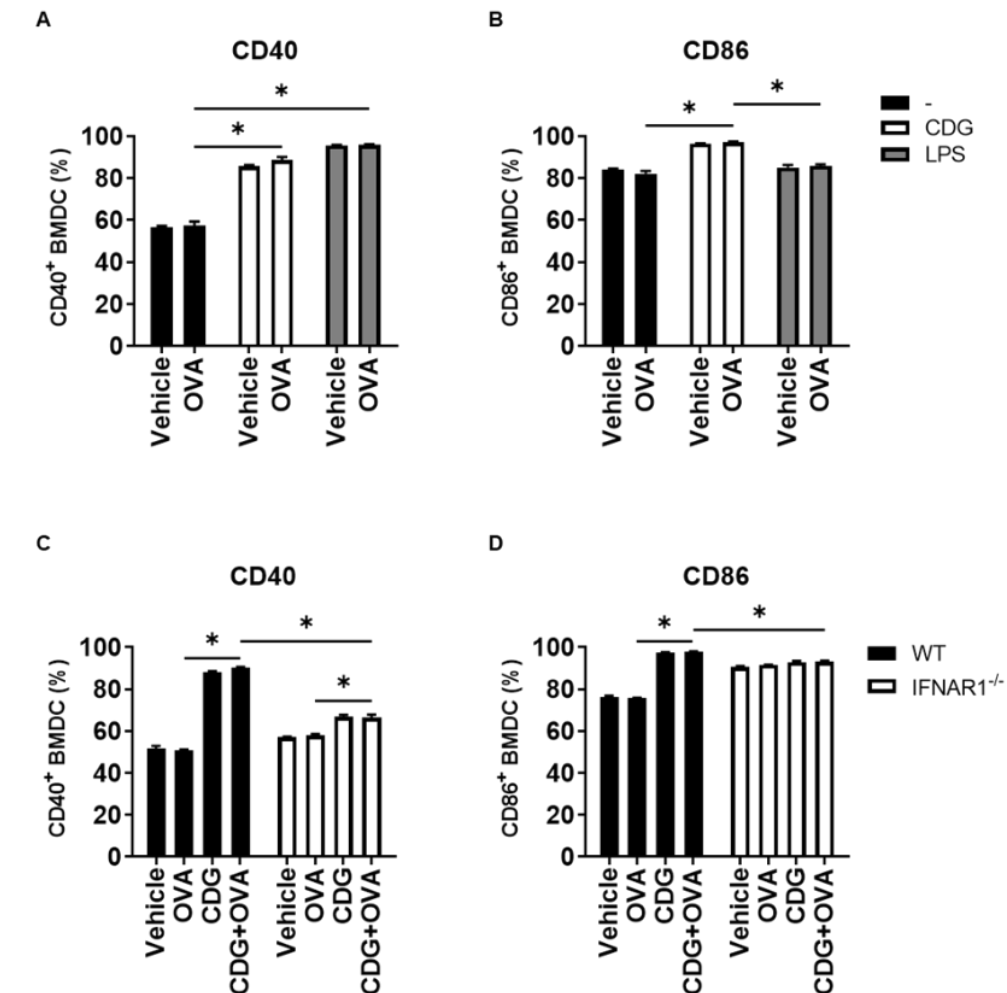
Figure 2. CDG-mediated upregulation of the costimulatory molecules CD40 and CD86 is type I IFN dependent. WT BMDC were treated with OVA +/ − CDG or LPS for 24 h. The frequency of ( A ) CD40+ and ( B ) CD86+ BMDC were quantified using flow cytometry. WT and IFNAR1 − / − BMDC were treated with OVA, CDG or OVA + CDG and the frequency of ( C ) CD40+ and ( D ) CD86+ BMDC were quantified using flow cytometry. Error bars indicate SEM. Statistical significance was calculated using a one-tailed Student’s t -test. * indicates p < 0.05. The results are representative of two independent experiments.